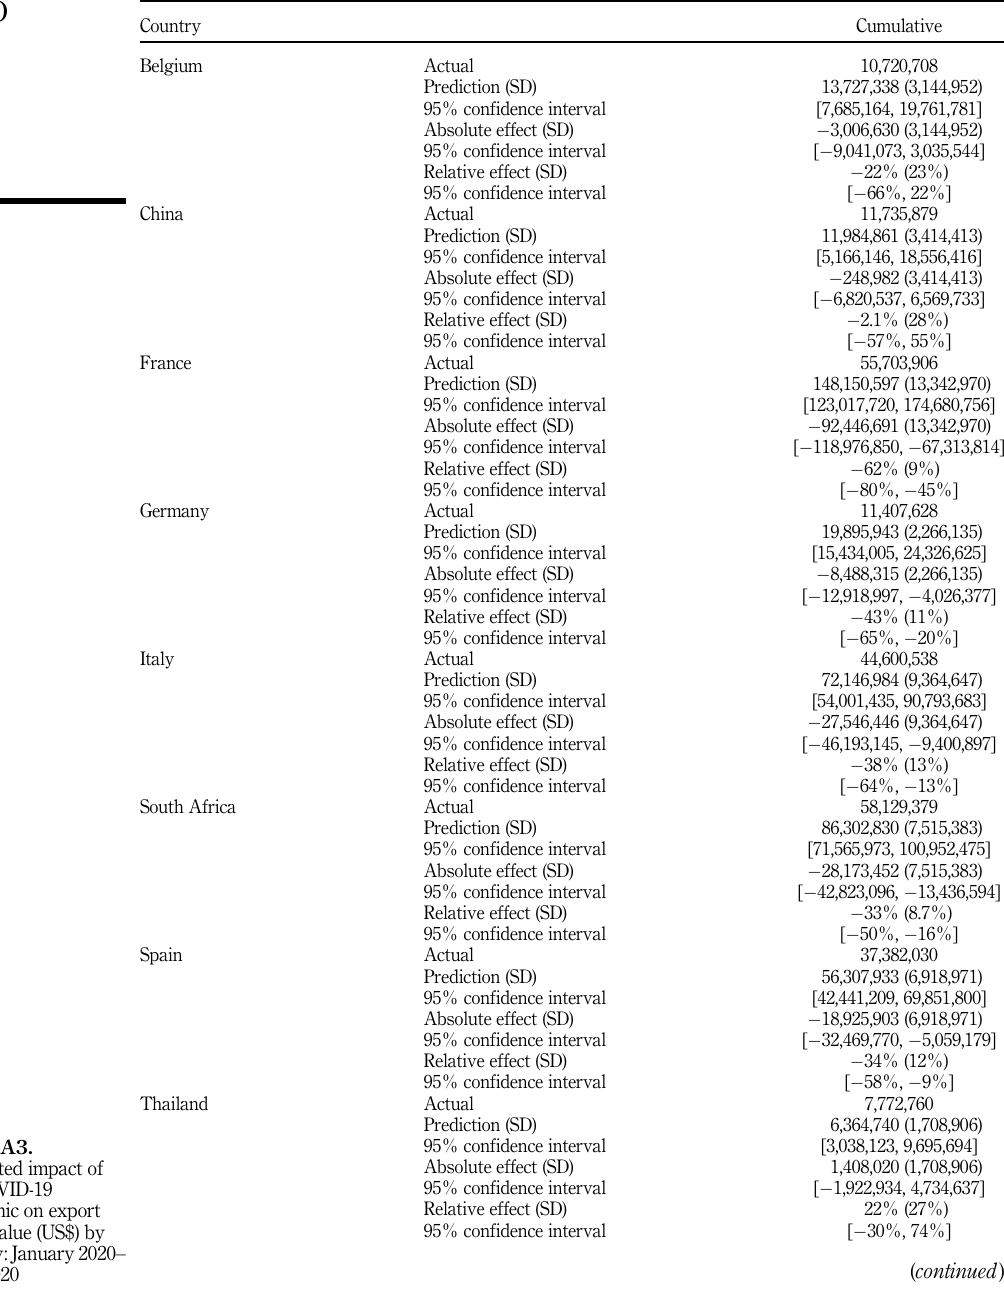
Table A3. Estimated impact of the COVID-19 pandemic on